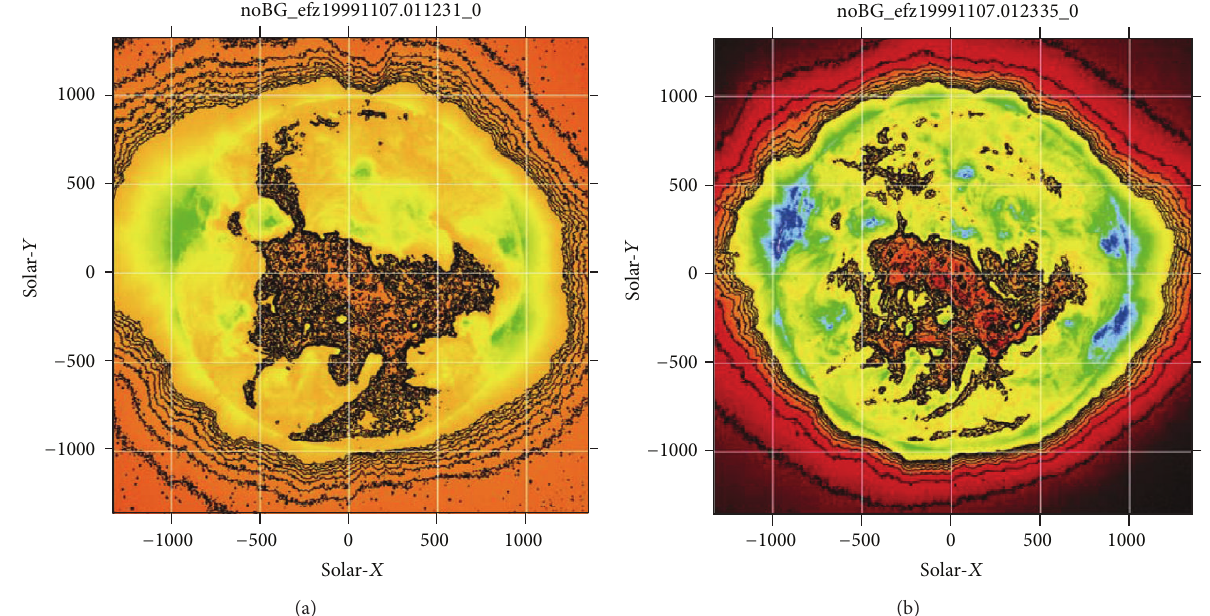
Figure 5: CH observed on 11 July 1999 at the wavelengths of 195 A (a) and 284 A (b).